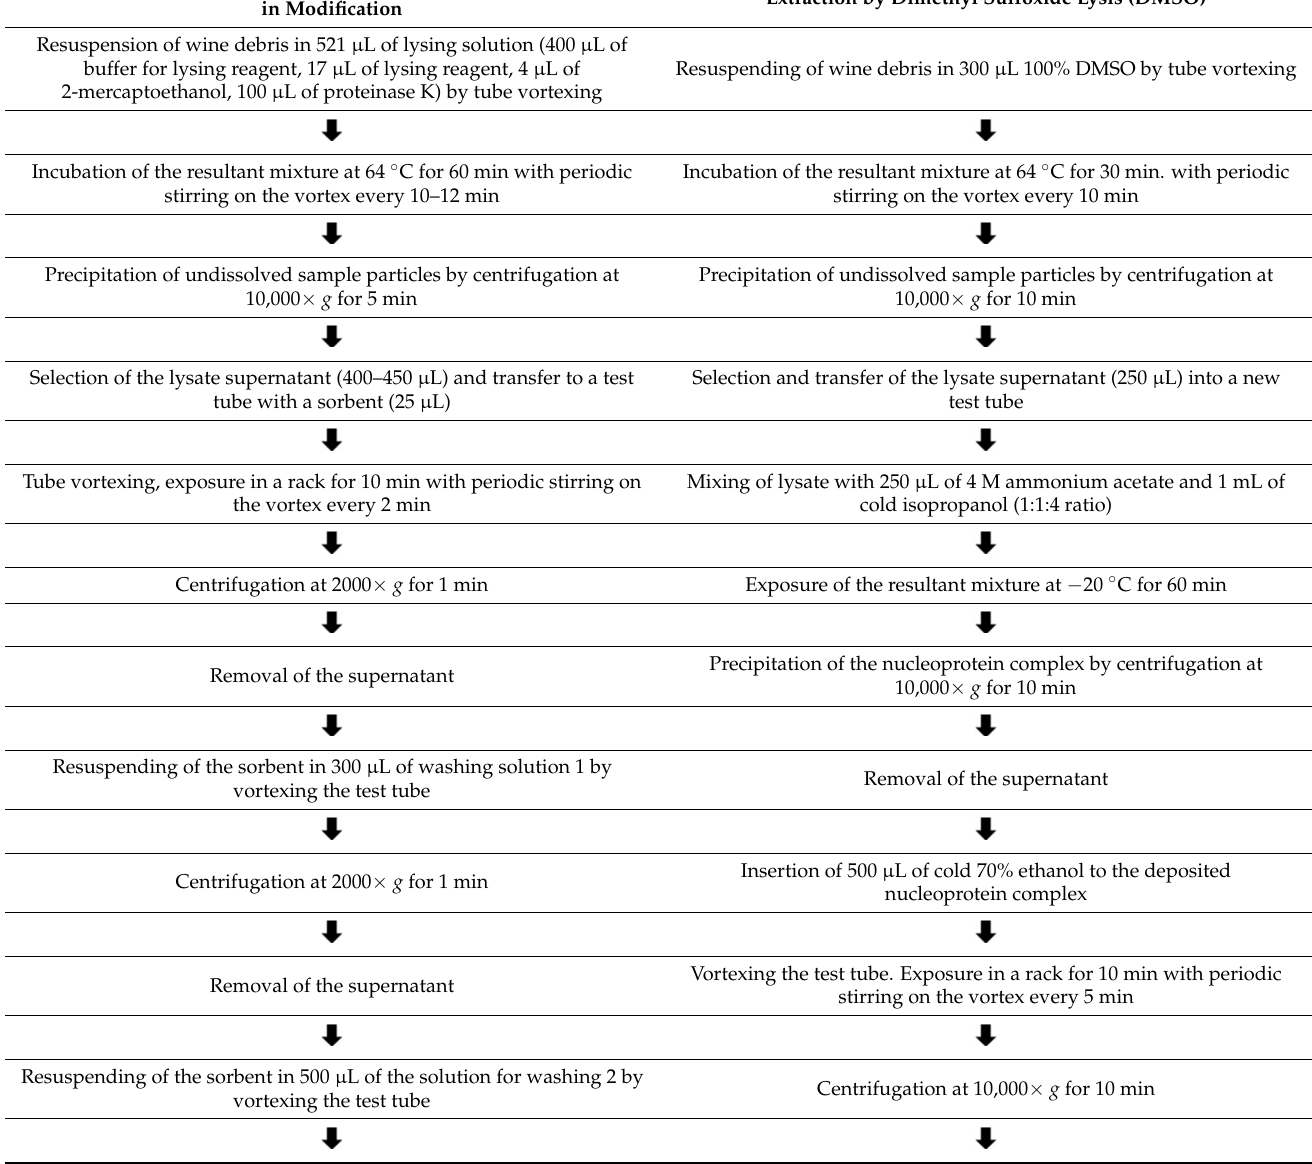
Extraction by Dimethyl Sulfoxide Lysis